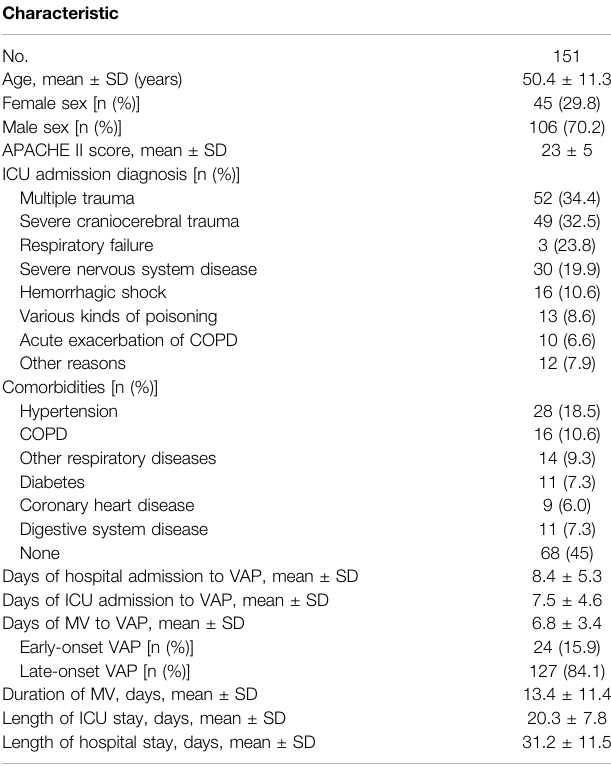
TABLE 1 | Clinical characteristics of patients treated for PA-VAP ( n = 151).